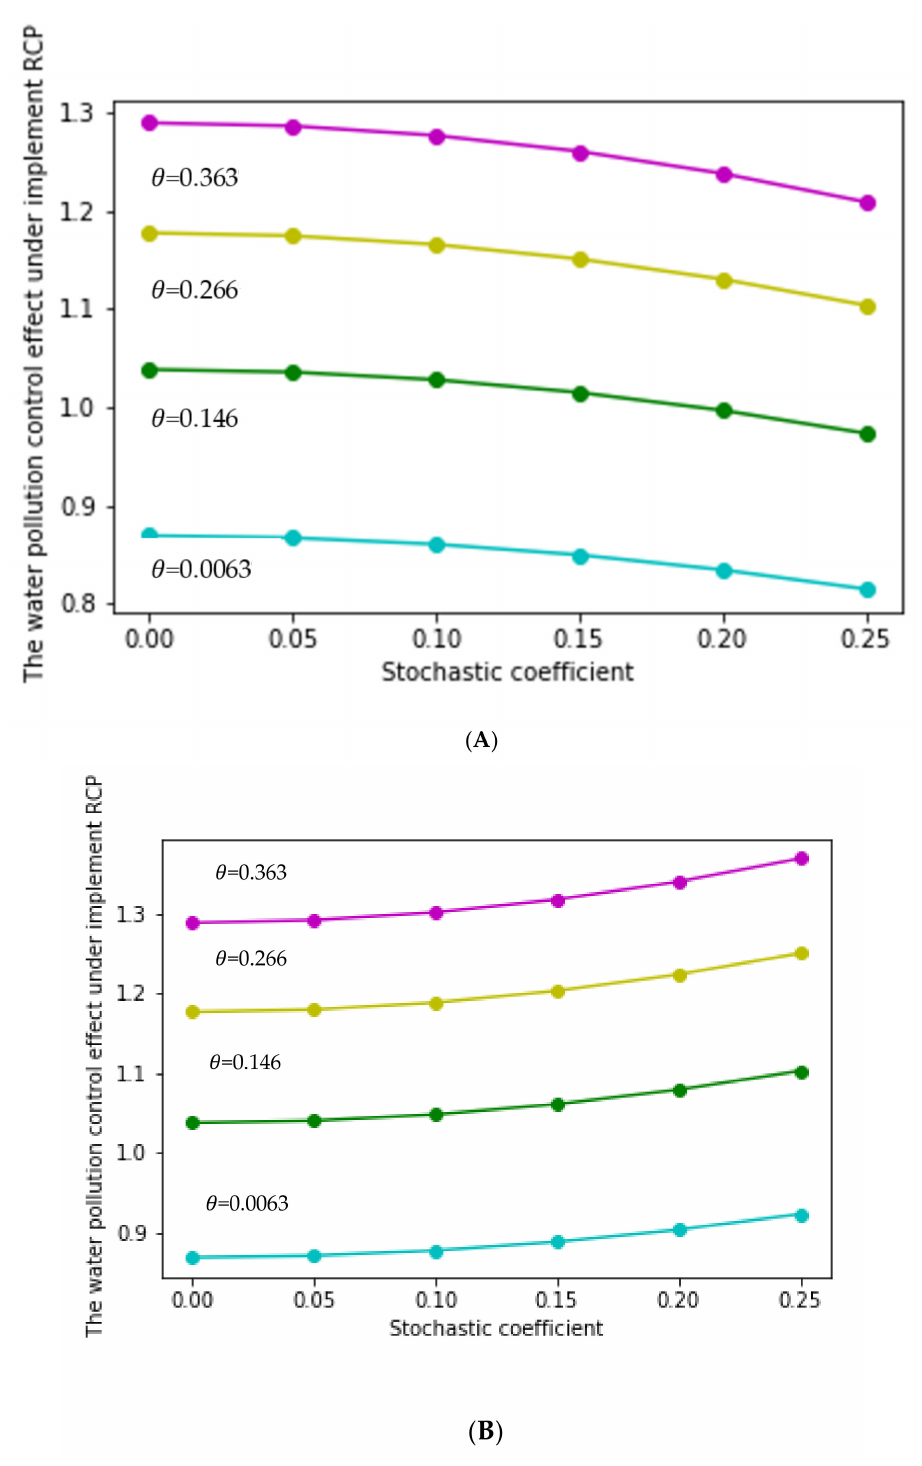
Figure 3. The RCP’s water pollution control e ff ect limit values under di ff erent θ values. ( A ) The RCP’s water pollution control e ff ect lower limit values under di ff erent θ values. ( B ) The RCP’s water pollution control e ff ect upper limit values under di ff erent θ